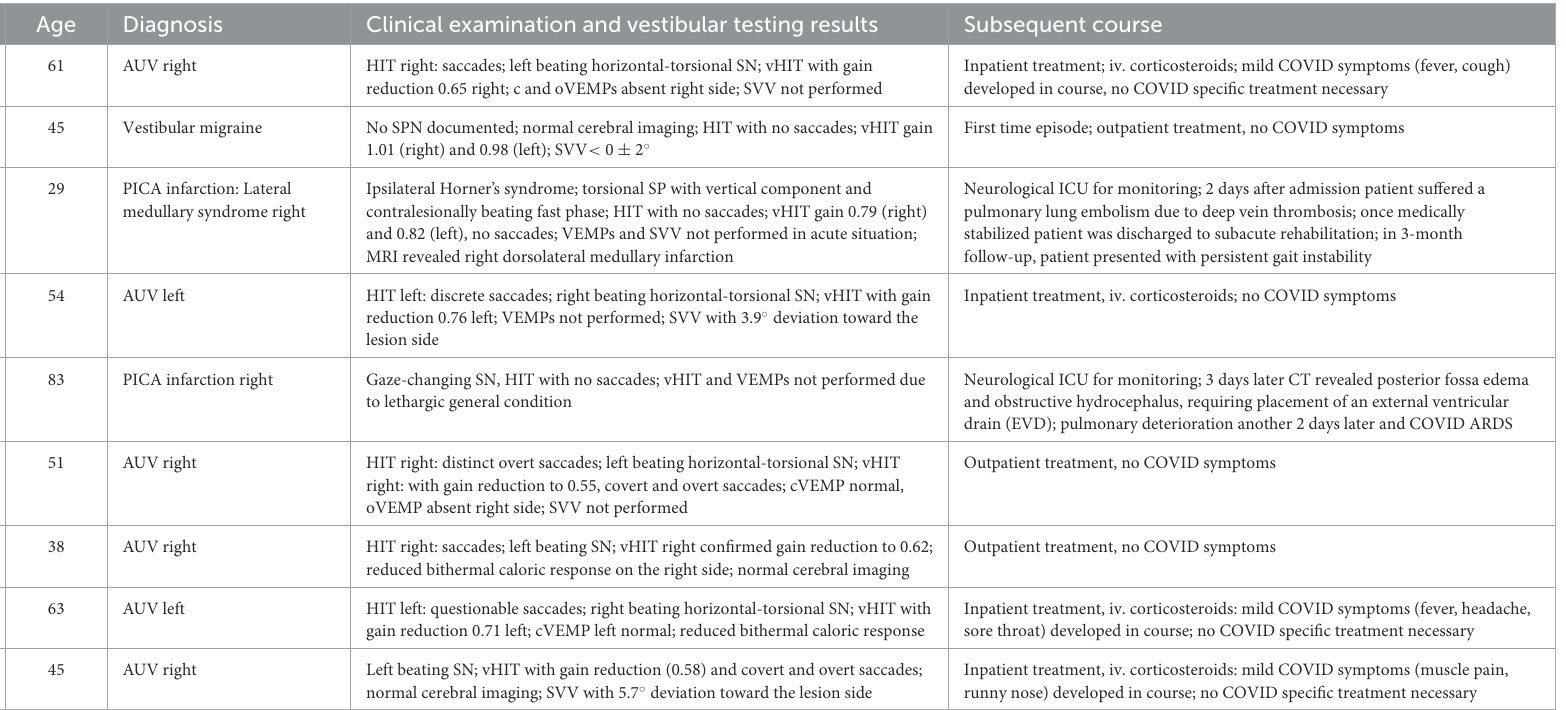
TABLE 4 Clinical findings, diagnoses, and subsequent courses of treatment in AVS-case series.